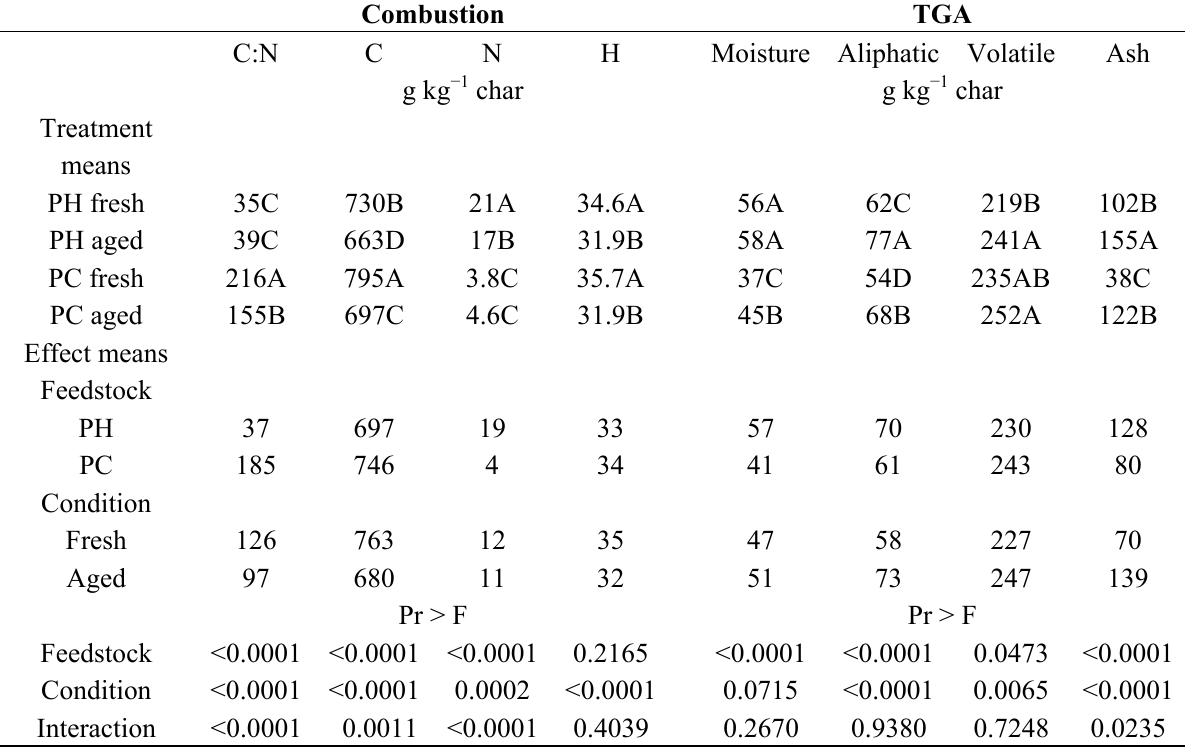
Different letters indicate treatment means are significantly different based on comparison of LSM at alpha